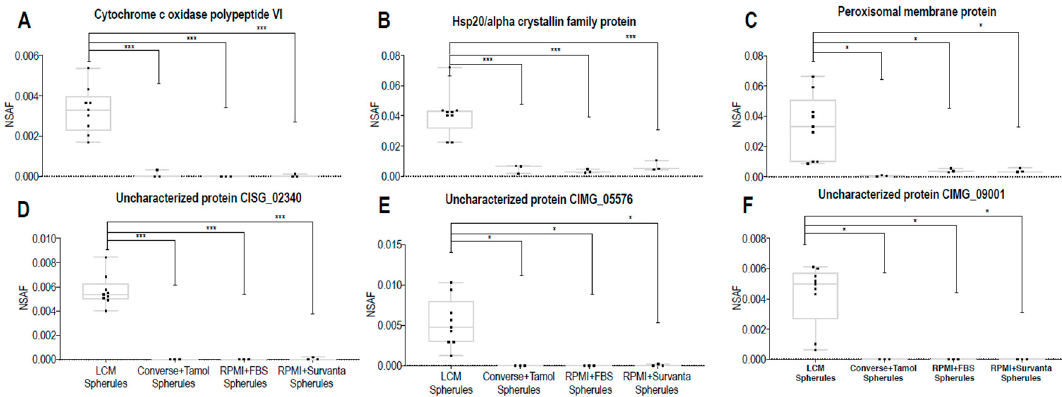
Figure 5. Box and whisker plots of differential protein abundances indicate that all biomarker candidate proteins can be produced in vitro, but abundance is dependent on culture media used. In vivo versus in vitro grown spherule abundances are shown for 6 proteins with the highest fold changes ( A – F ). Significance was calculated using one-way ANOVA adjusted for multiple comparisons using Holm–Sidak method (* p < 0.05, *** p < 0.001).